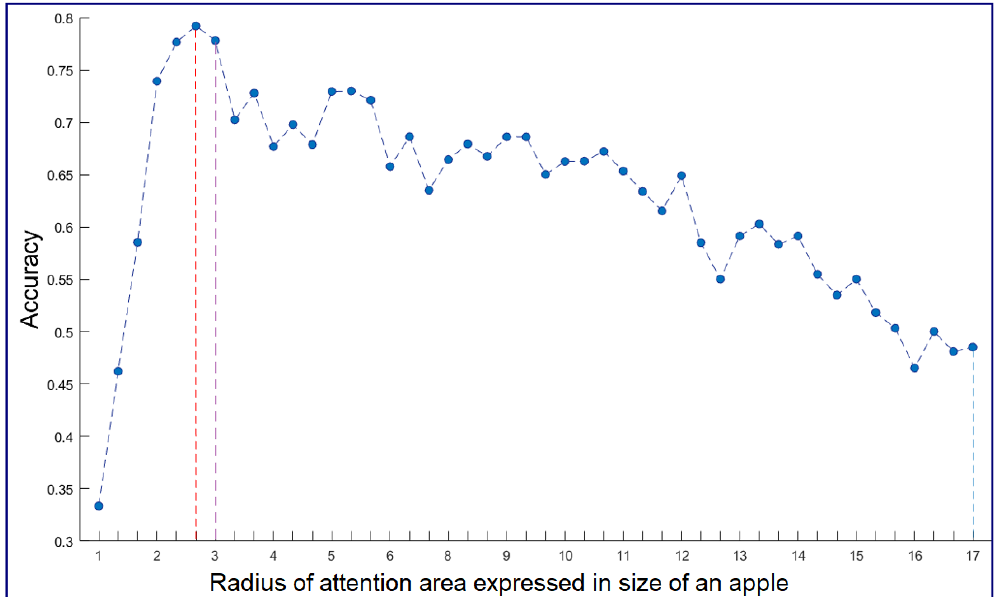
Figure 6. Apple segmentation accuracy as a function of the radius of attention area expressed in the size of apples taken as 30 pixels. Maximum accuracy achieved when the radius size of the attention map is equal to 80 (160 × 160 pixels) corresponding to the red dotted line. The purple dotted line corresponds to the maximum gaze shift error of (169 pixels) between eye-tracker and ground-truth when computed on the whole